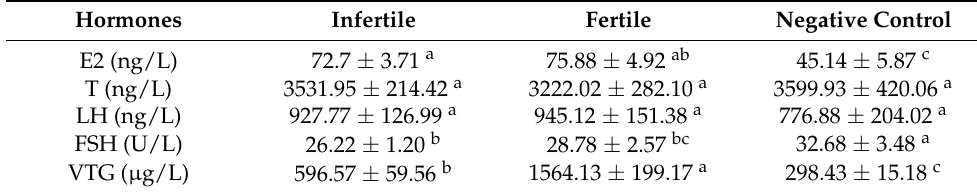
Table 1. Hormone concentration in infertile, fertile, and negative control Japanese flounder.